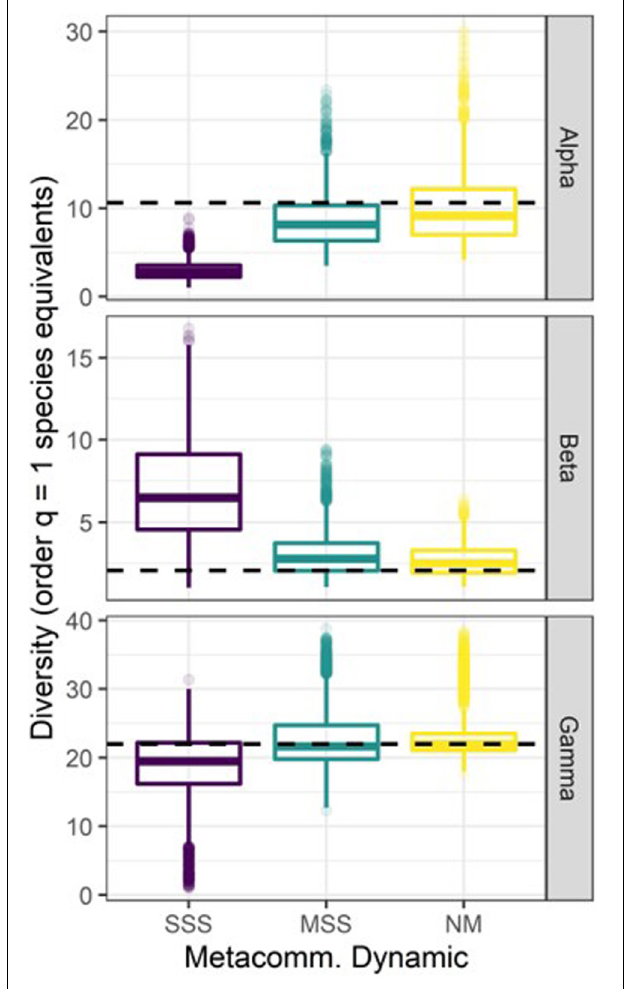
FIGURE 6 | Diversity outcomes for the final time step ( t = 100) of the simulated metacommunities. Diversity partitions follow the Jost (2007) order q = 1 multiplicative method to calculate diversity at alpha (patch), beta (turnover among patches), and gamma (metacommunity) scales. Outcomes are displayed separately for scenarios with strong species sorting (SSS), moderate species sorting (MSS), and neutral model (NM) metacommunity dynamics. Dashed lines indicate initial diversity partitions at t = 1, which were the same for all 10,000 simulations.